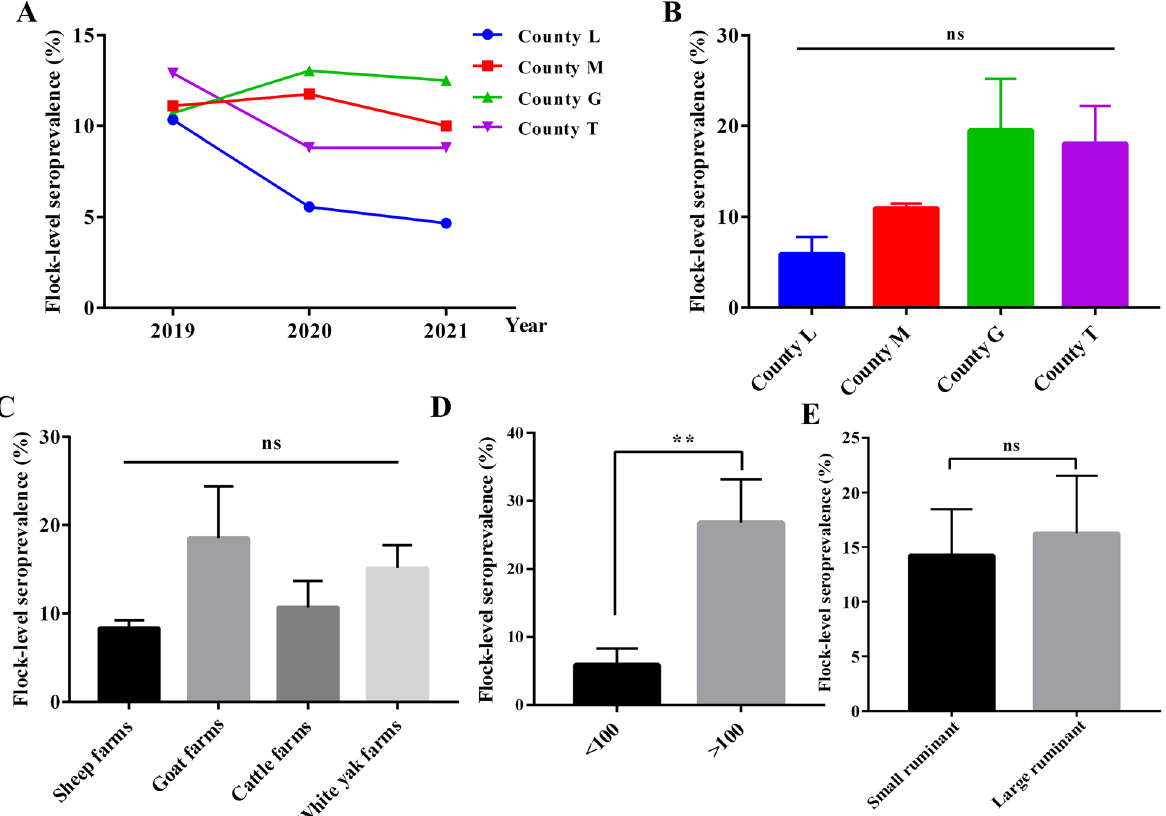
Fig. 1 The flock-level seroprevalence of animal brucellosis from 2019 to 2021. A The trend of flock-level seroprevalence in 4 counties from 2019 to 2021. The Y-axis represents the average flock-level positive rate of the county with seroprevalence % B Differential analysis of seroprevalence in different counties; C Differential analysis of seroprevalence in different species of farms; D Differential analysis of seroprevalence in different flock sizes of farms; E Differential analysis of seroprevalence in small and large ruminant farms. ns: no significant difference at P > 0.05. * Significant difference at P < 0.05. ** Extremely significant difference at 0.01 < P <